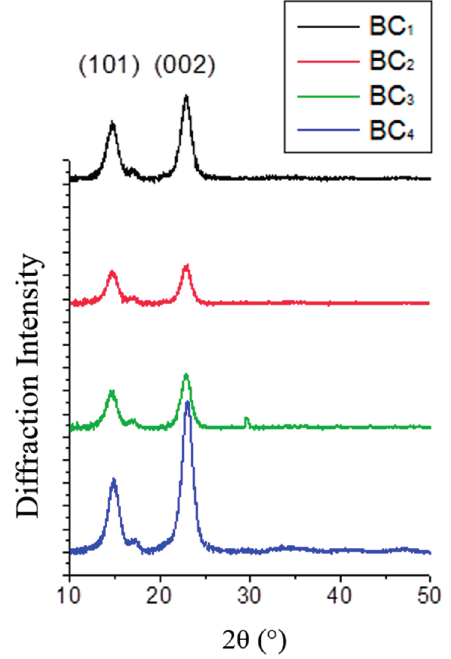
Figure 6. XRD diffraction patterns of bacterial cellulose